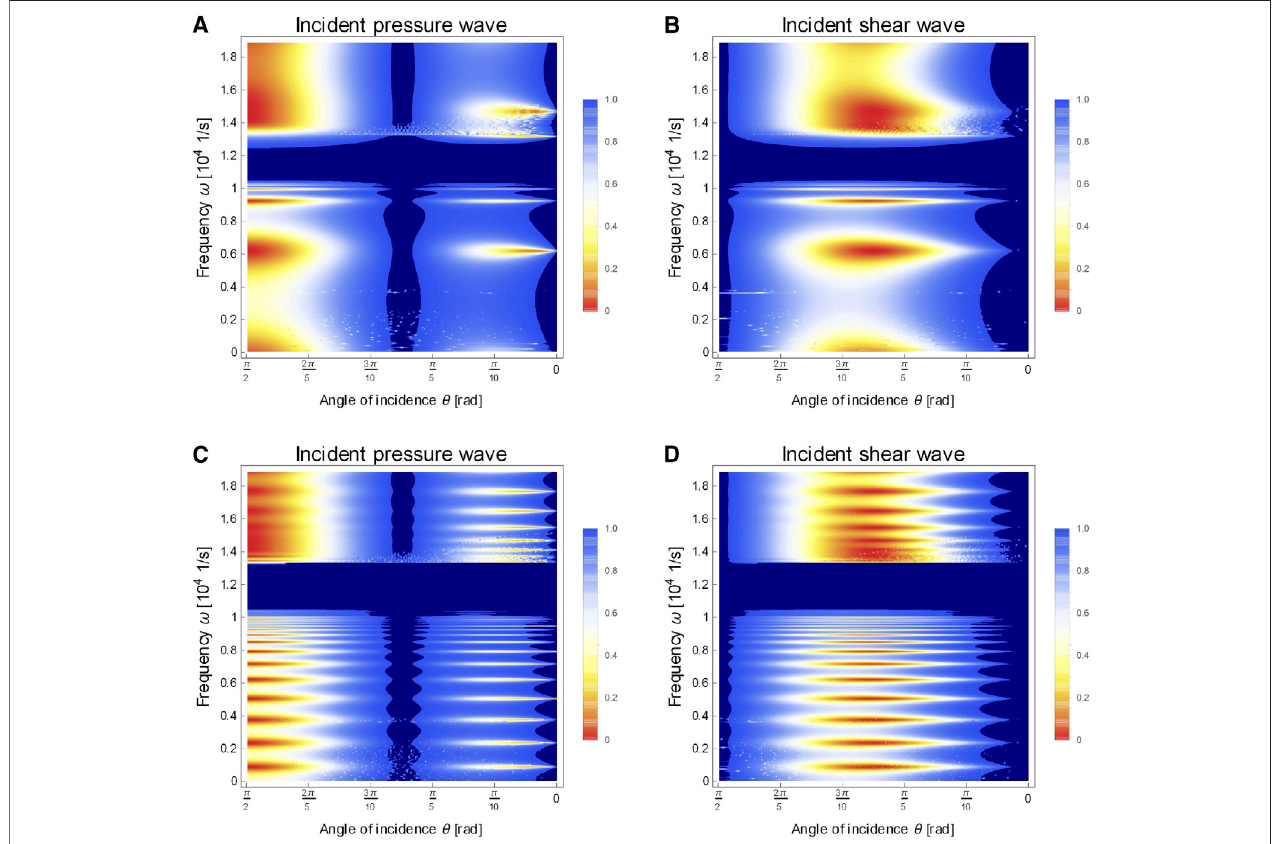
FIGURE 14 | Simulation of the re fl ection coef fi cient with the obtained relaxed micromorphic model for a 20 (A, B) and a 100 (C, D) unit cells thick slab made up of MM1 material and embedded in CM2 Cauchy as function ofthe angle of incidence and of the wave-frequency – (A) and (C) : incident pressure wave; (B) and (D) incident shear